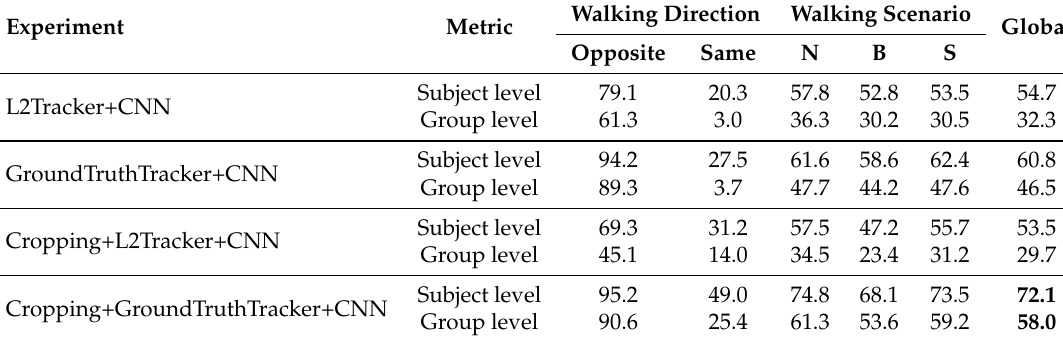
Table 2. Accuracy on MultiTUM-GAID. Each row represents a different granularity of the experiment. Each column represents a different test scenario. Best global results are marked in bold. More details in the